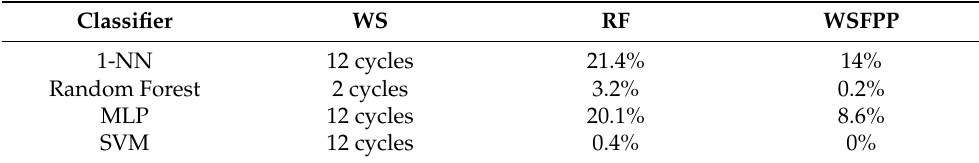
Table 3. Results summary. Column WS shows the window size, RF the result with the Reference System, and WSFPP when our proposal is used with n = 12. Module is used in the acquisition stage and frequency domain in the feature extraction stage, except for 1-NN, which performs better in the time domain.